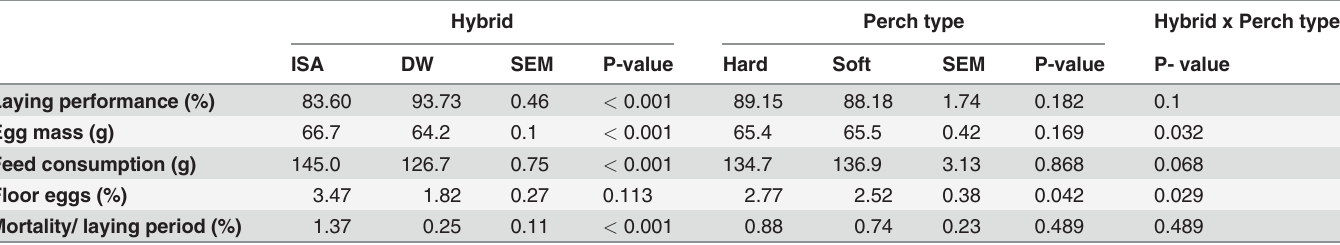
Table 3. Production data for genetic line (DW/ ISA) and perch type (hard/ soft), N = 20. Hybrid Perch type Hybrid x Perch type ISA DW SEM P-value Hard Soft SEM P-value P-